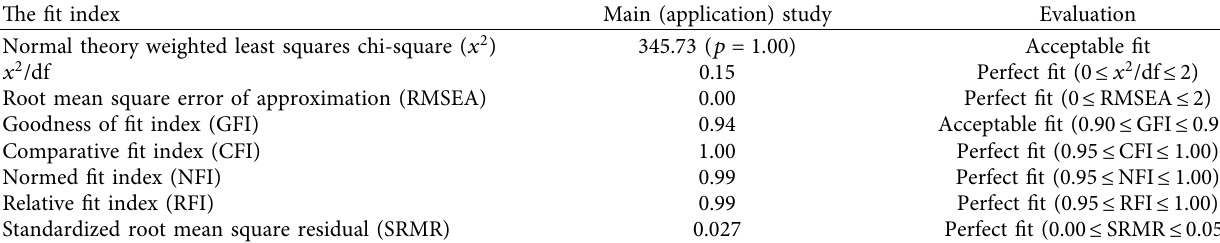
Table 5: Evaluation of the fit of the model according to the goodness of fit criteria.